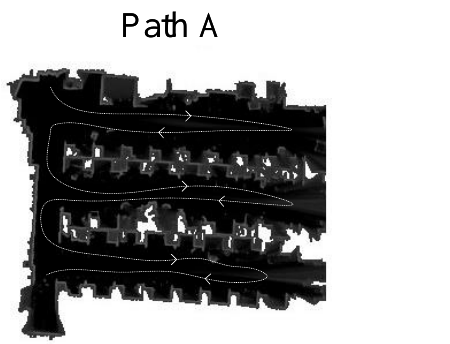
Figure 9. Paths of